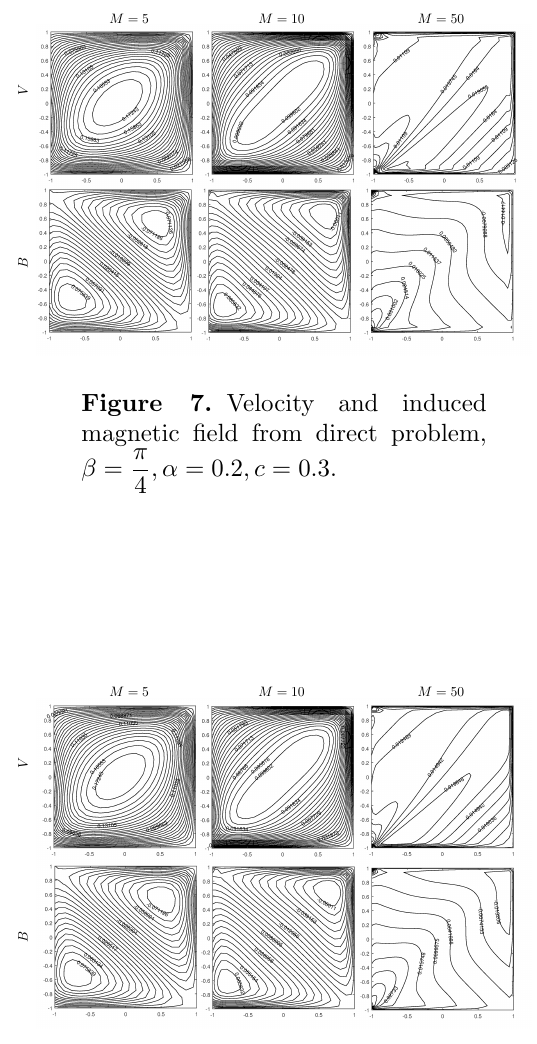
Figure 8. Velocity and induced magnetic field from inverse solution, π . β = 4